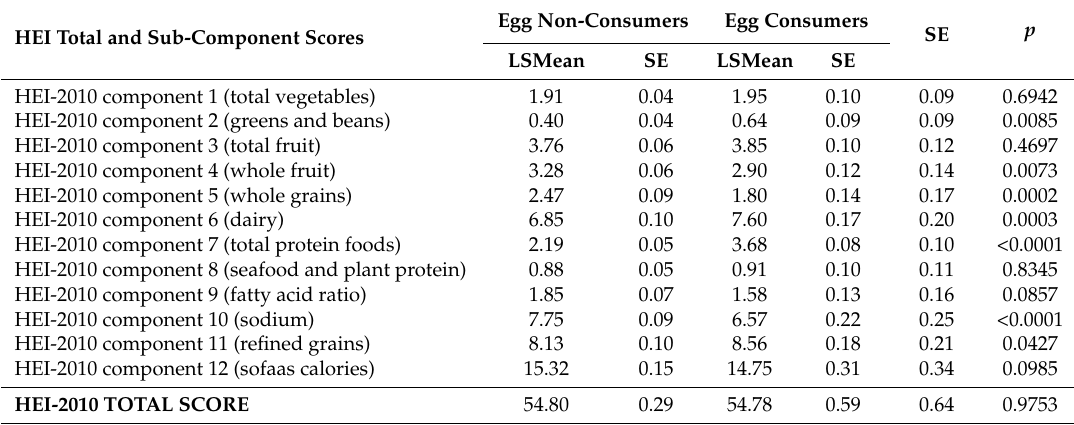
Table 3. Adjusted mean (SE) Total Healthy Eating Index-2010 (HEI) and Sub-Component Scores for egg consumers vs. egg non-consumers using NHANES 2001–2012; 6–24 months old. Egg Non-Consumers Egg HEI Total and Sub-Component Scores